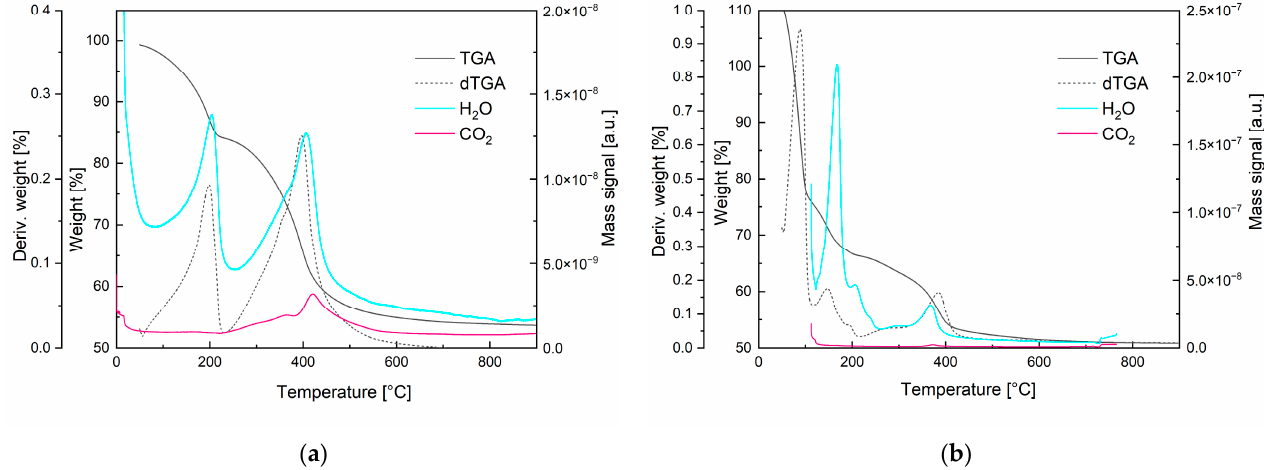
Figure 1. TGA and DTG analysis, with H 2 O and CO 2 mass spectrometry, ( a ) MgAl, ( b ) MgAl REH.